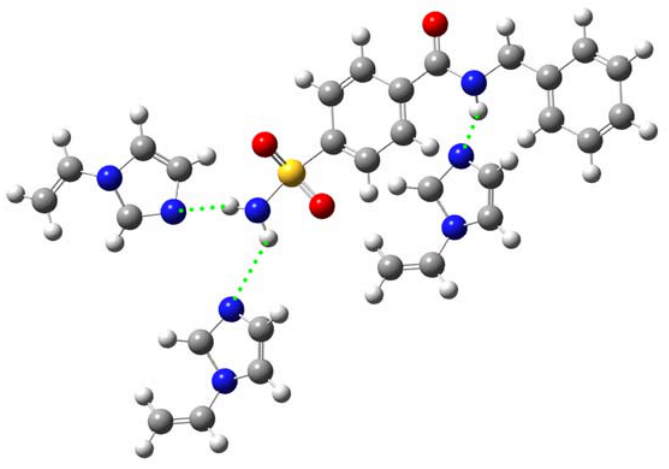
Figure 4. Proposed mode of interaction of template 1 with VIM via two H-bondings, particularly the interaction of nucleophilic imidazole N-atom of VIM with amino group of sulfonamide and the H-bonding of imidazole N-atom of VIM with central amide NH.